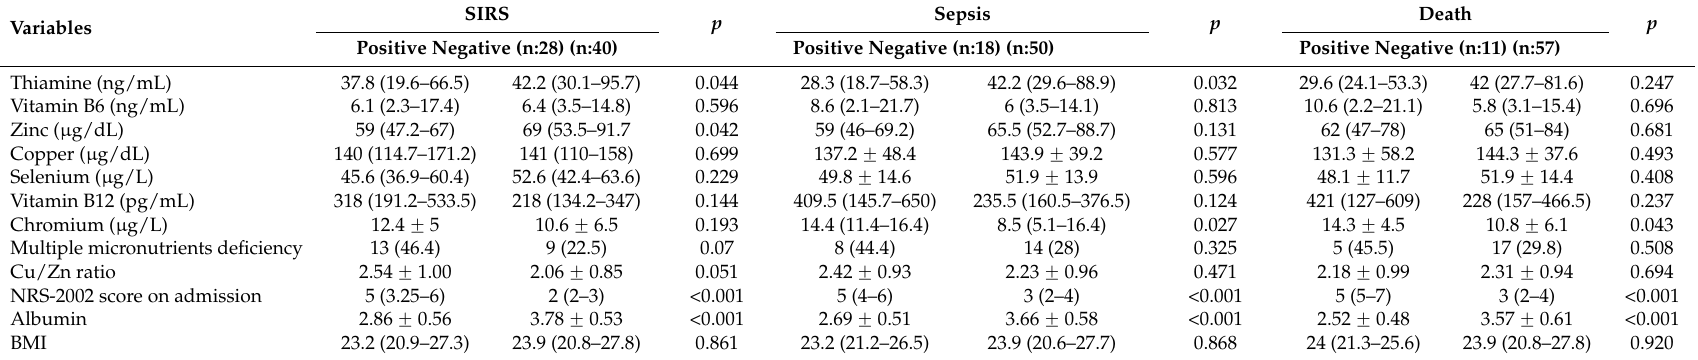
Table 2. Comparison of the micronutrients and nutritional characteristics of patients divided into groups according to SIRS, sepsis and death.